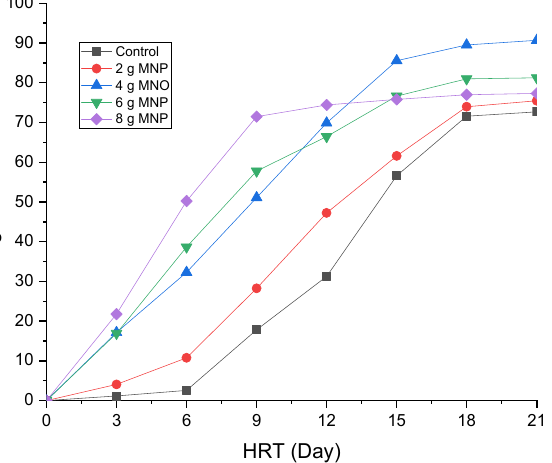
Figure 4. Degradation of chemical oxygen demand (COD) for the five digesters over the optimum AD period.